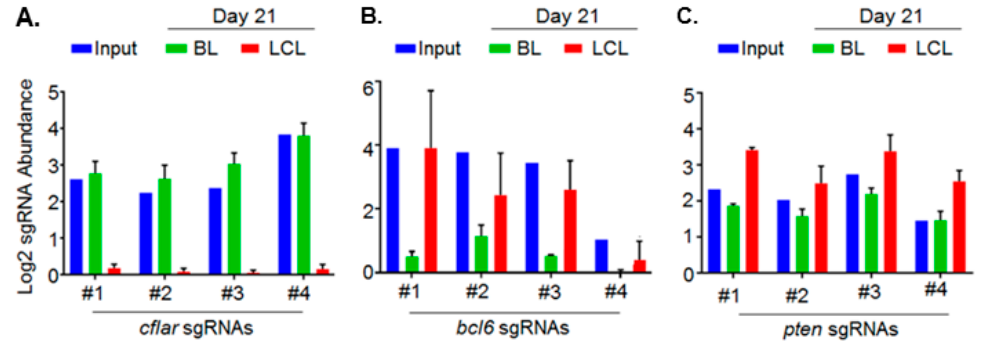
Figure 4. Representative Epstein–Barr (EBV)-transformed B cell CRISPR-pooled screen hits. ( A ) Log2 abundances of the four Avana library sgRNAs that target CASP8 And FADD Like Apoptosis Regulator ( cflar ), which encodes Cellular FLICE-Like Inhibitory Protein (cFLIP), in the indicated populations. All four cflar targeting sgRNAs are markedly depleted from the day 21 LCL pool, but not from the day 21 BL cell pool, relative to input levels, suggesting a key cFLIP role as an LCL-selective dependency factor; ( B ) all four Avana sgRNAs targeting B-cell lymphoma 6 ( bcl6 ) are depleted from the day 21 BL pool and to a significantly lower extent from the day 21 LCL pool, indicating a BL-selective dependency factor role; ( C ) all four sgRNAs against the Phosphatase And Tensin Homolog ( pten ) are enriched compared to input levels in the day 21 LCL pool, suggesting that PTEN loss enhances LCL growth and/or survival.